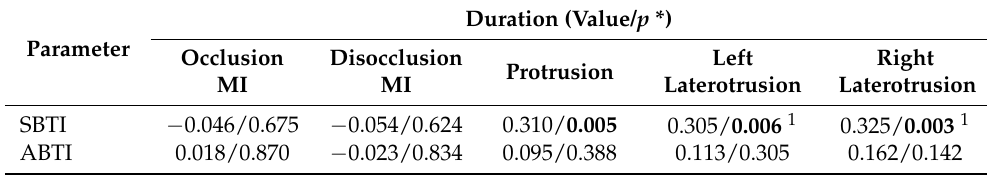
Table 14. Correlations between duration of mandibular movements and bruxism time indices. Parameter